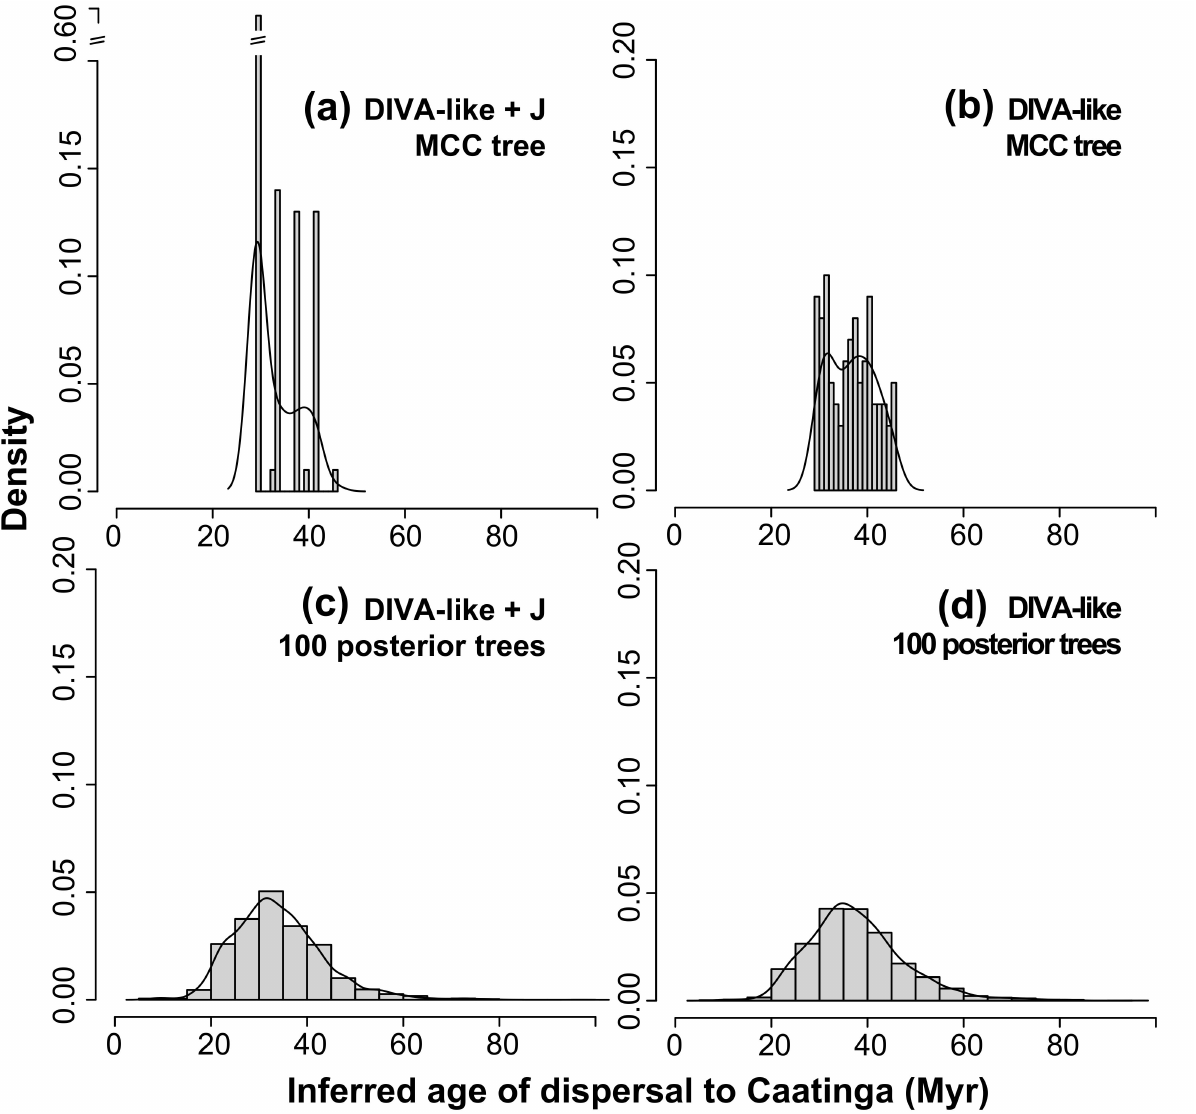
Figure 7. Histograms with the inferred age of dispersal of Sicarius to the Caatinga. Analyses based on a maximum clade credibility tree (MCC tree) ( a , b ) produce sharper estimates closely tied to the ages of cladogenetic events in this tree. This is especially notable in the model including founder-event speciation ( a ), which displays four peaks, each associated with the age of the four successive nodes in the tree that could have originated the founder-event dispersal to the Caatinga. Accounting for uncertainty in topology and age estimates ( c , d ) reveals that the age of dispersal is much more